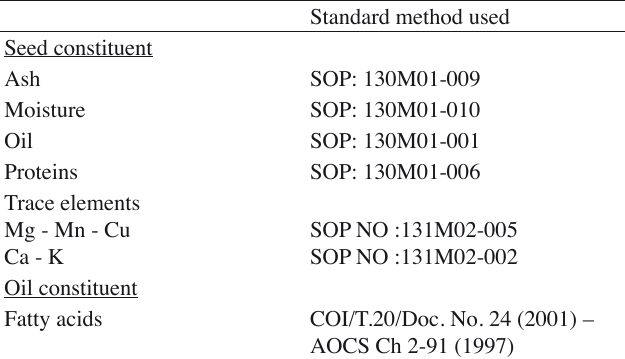
Table 1 - Analyzed constituents for Coriandrum